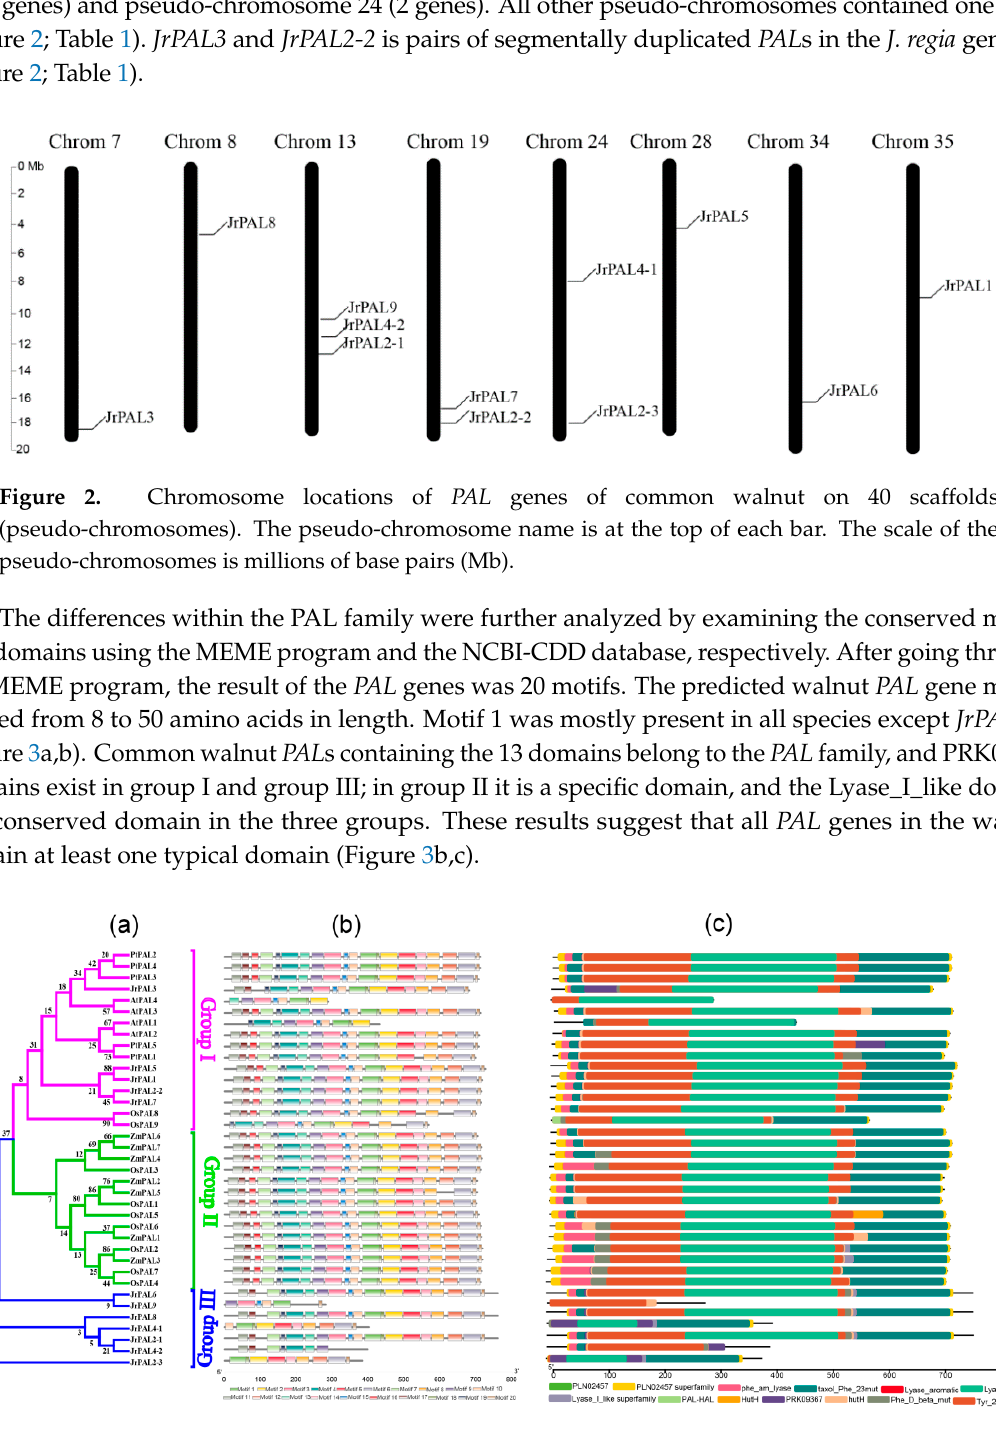
Figure 3. ( a ) Phylogenetic relationships, ( b ) motif compositions, and ( c ) conserved domains of the 12 PAL genes identified in the common walnut. Phylogenetic relationships used the neighbor-joining (NJ) method, and different colors represent different groups. Colored boxes indicate conserved motifs and gray lines represent nonconserved sequences. The lengths of motifs in each protein are shown proportionally.